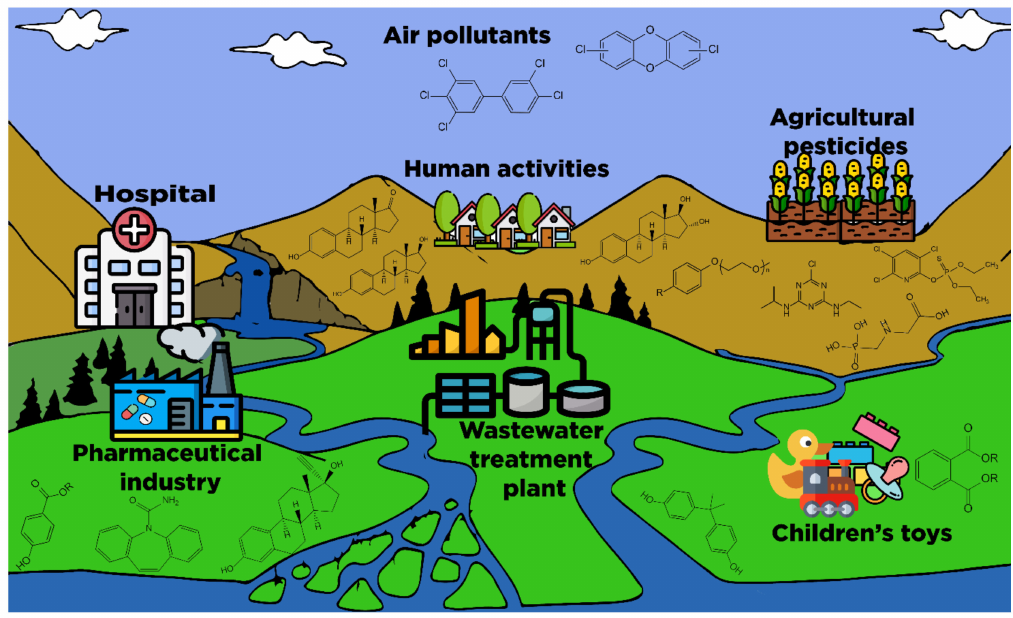
Figure 2. Sources of endocrine disruptors in the aquatic